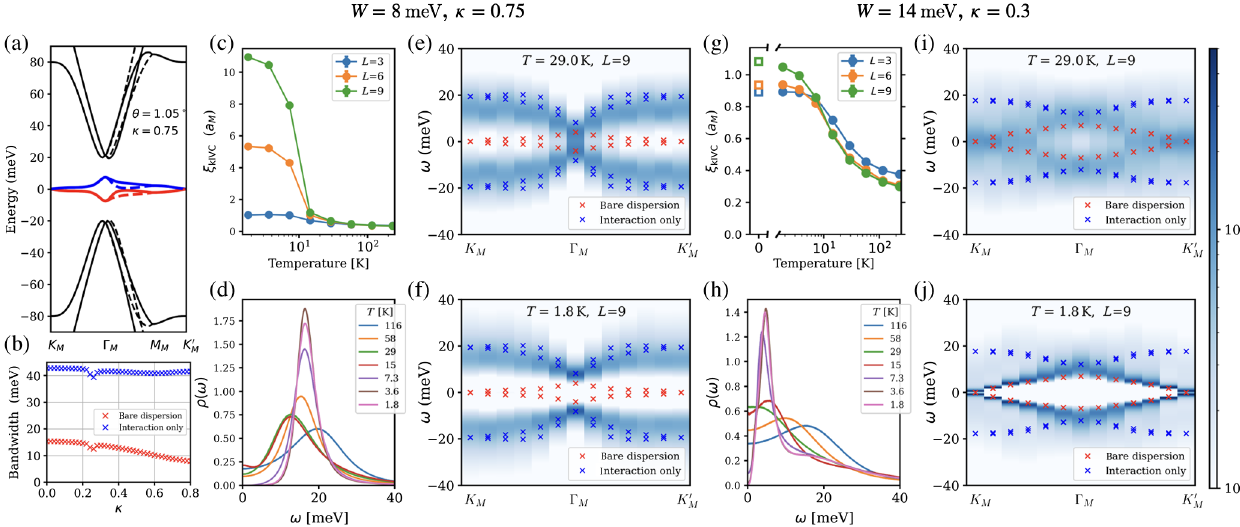
ˆ H 0 in Eq. (6)]. In the DQMC simulations, we project ˆ H 0 as a ˆ H 0 is neglected R d 2 k A ð ω ; k Þ , and (e,f) spectral function A ð k ; ω Þ along a ˆ H 0 ,